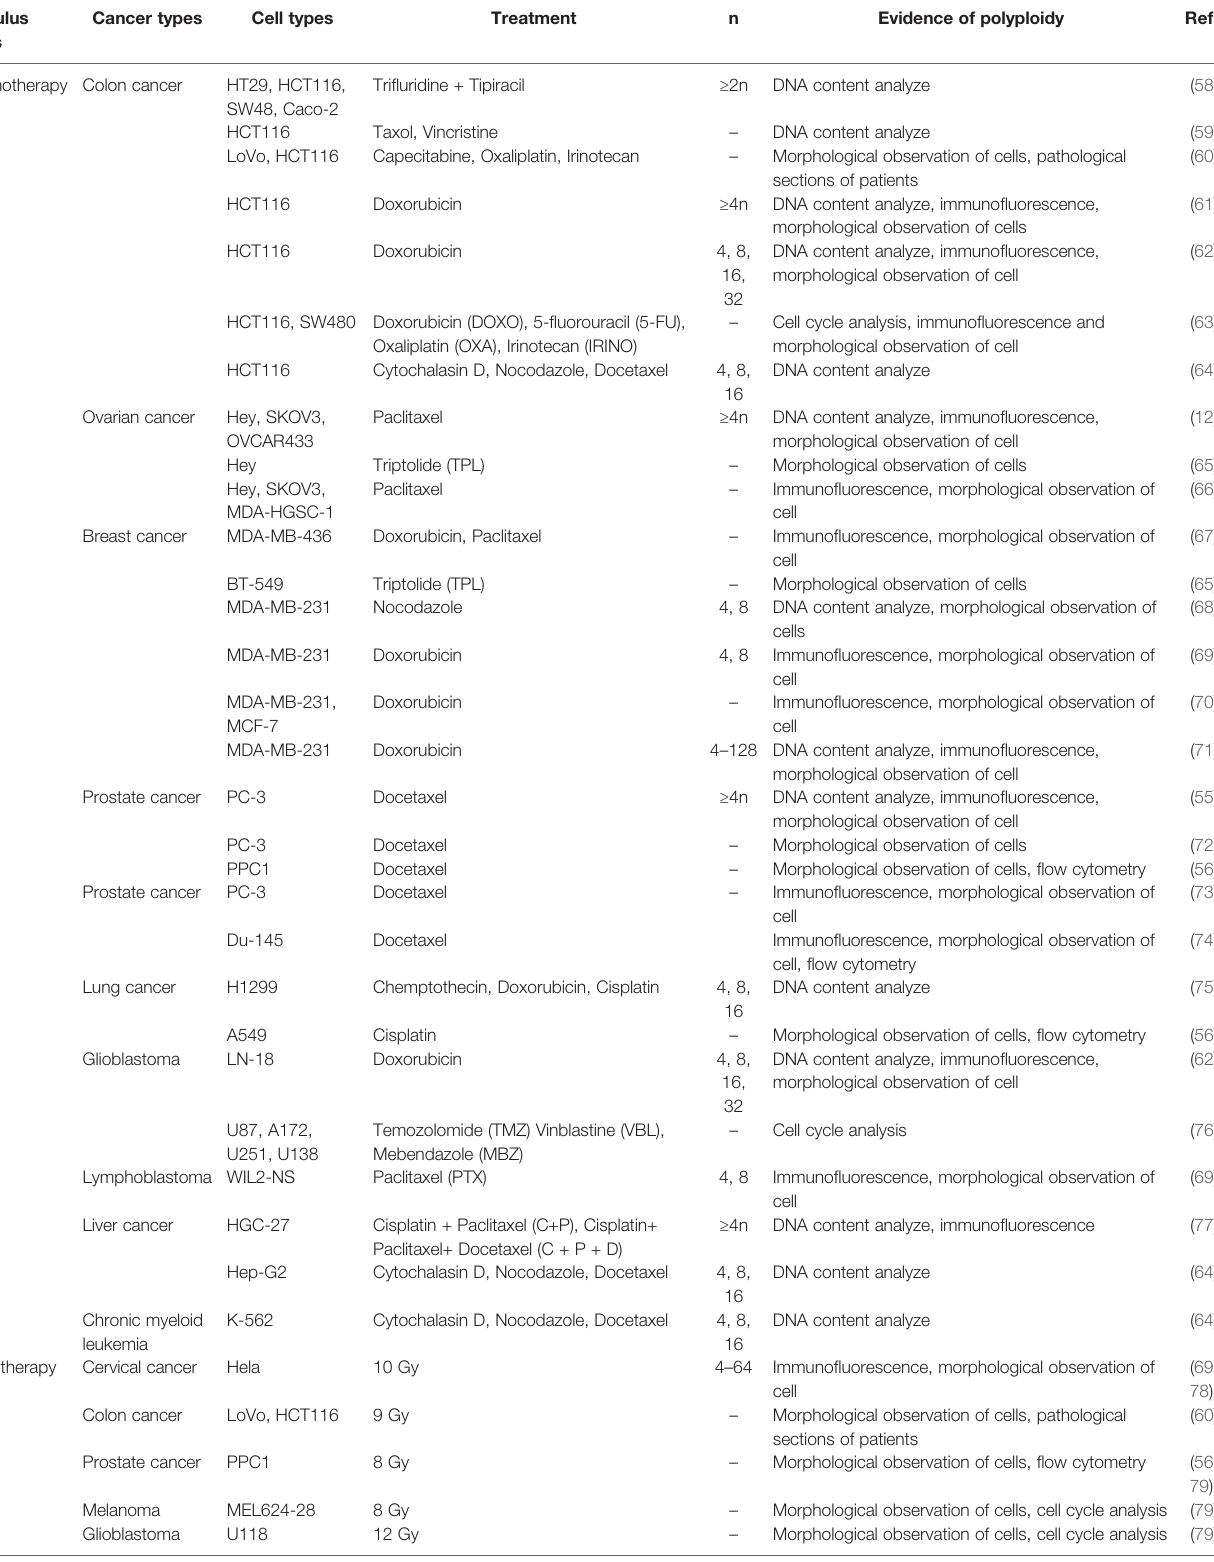
TABLE 1 | Several kinds of stress that can induce polyploidization of tumor